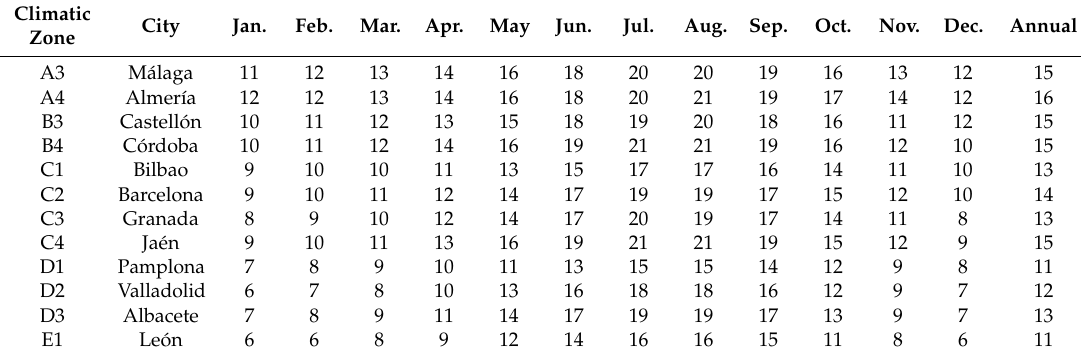
Table 4. Tap water monthly and annual mean temperature in °C.